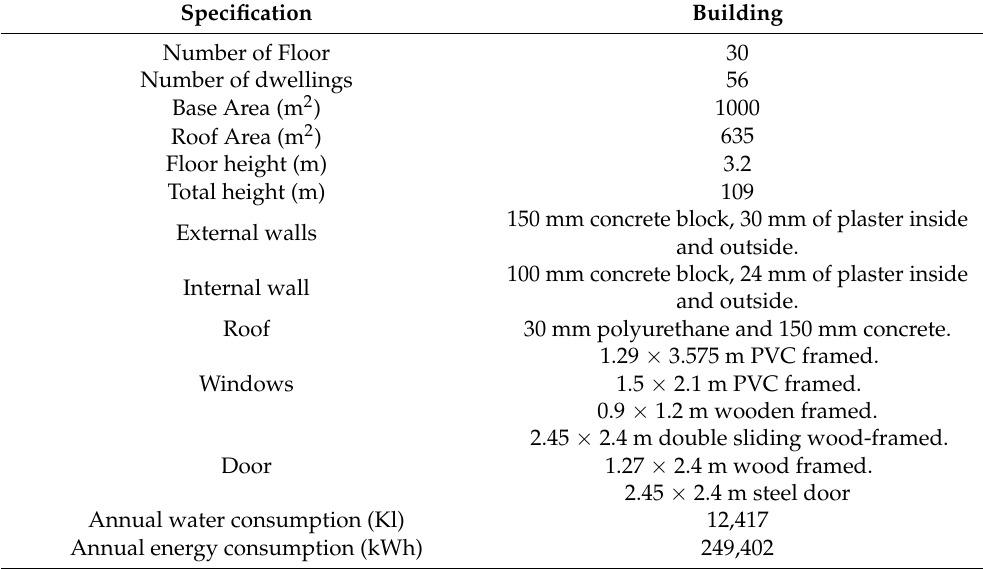
Table 2. Description of the selected